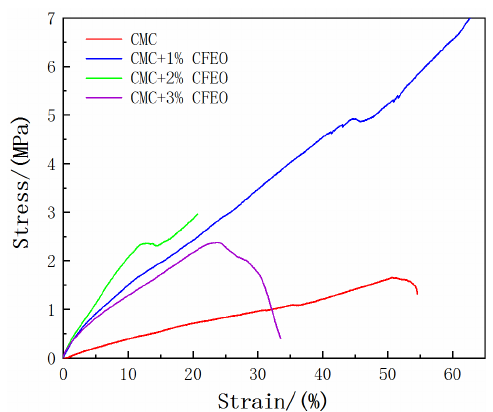
Figure 6. Stress-strain curves for CMC film and blended CMC-CFEO films with various concentra- tions of CFEO.